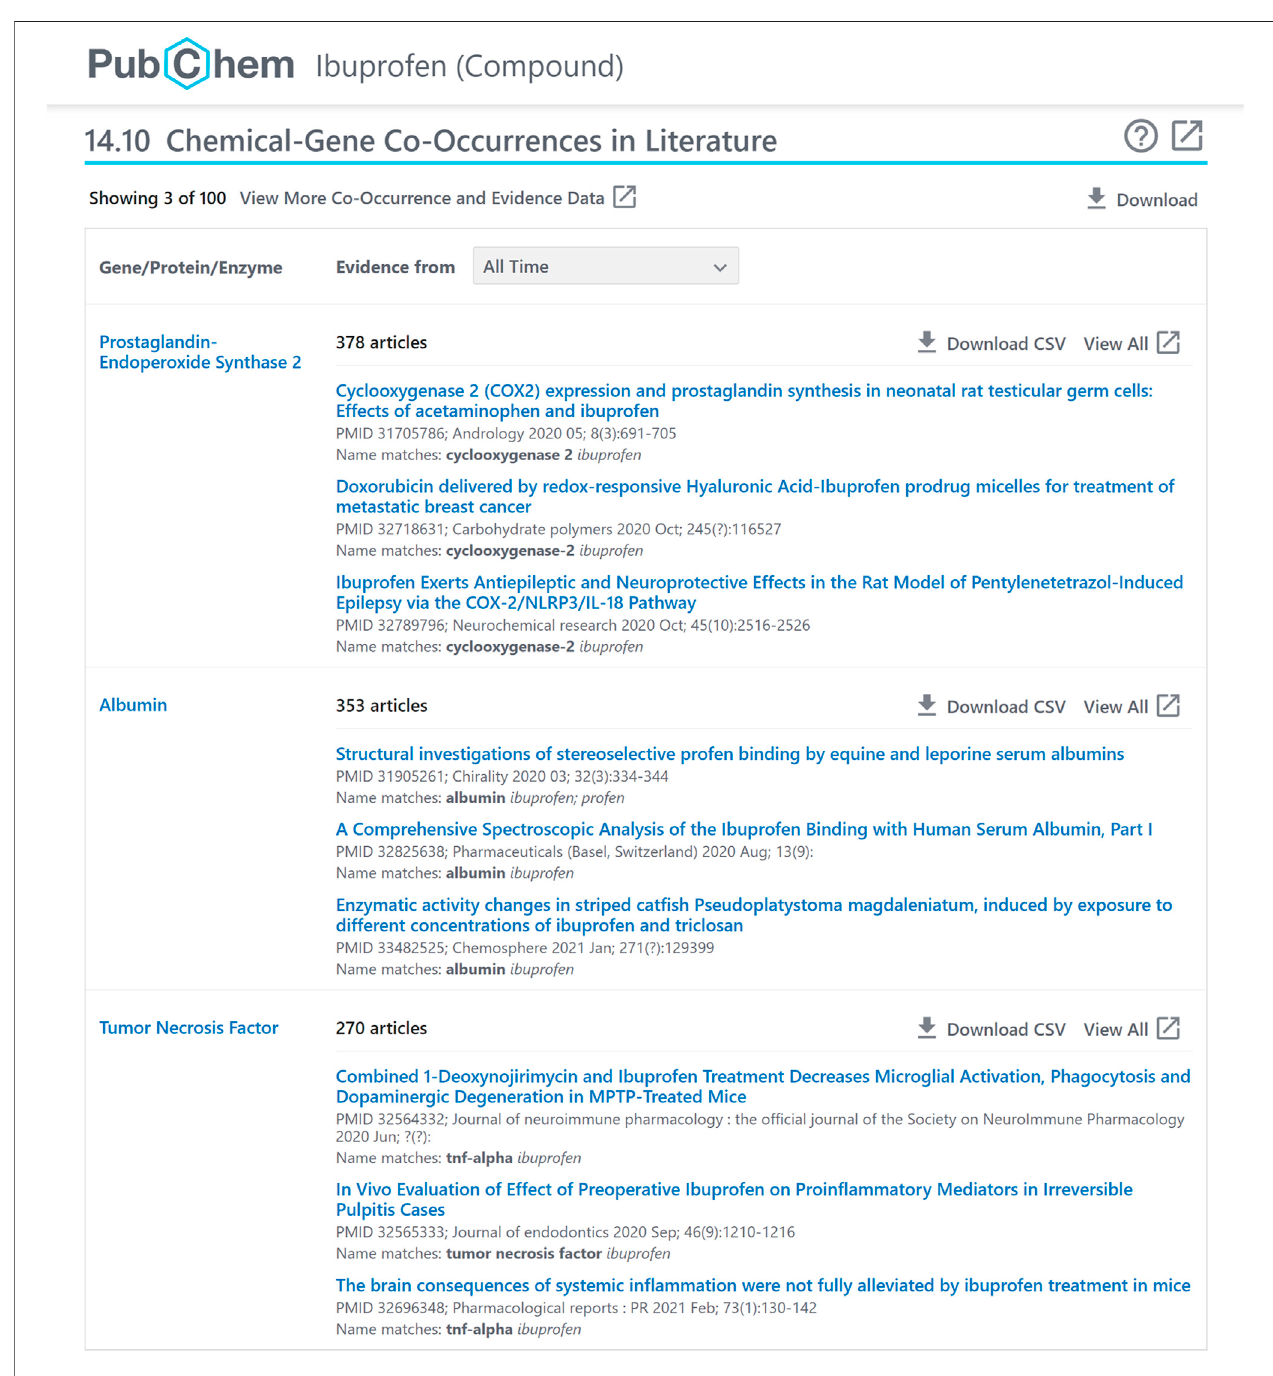
FIGURE 2 | A chemical-gene co-occurrence panel for ibuprofen (CID 3672), accessible at: https://pubchem.ncbi.nlm.nih.gov/compound/ 3672#section (cid:2) Chemical-Gene-Co-Occurrences-in-Literature.